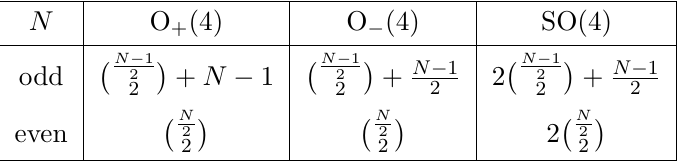
Table 5 . The total number of ground states of the O (cid:6) (4)